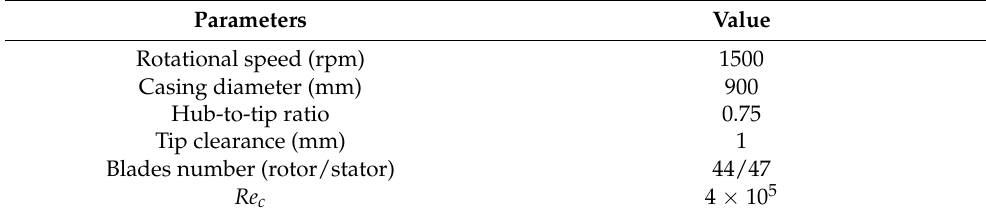
Figure 1. Sketch of the experimental rig. Table 1. Key parameters of the compressor.